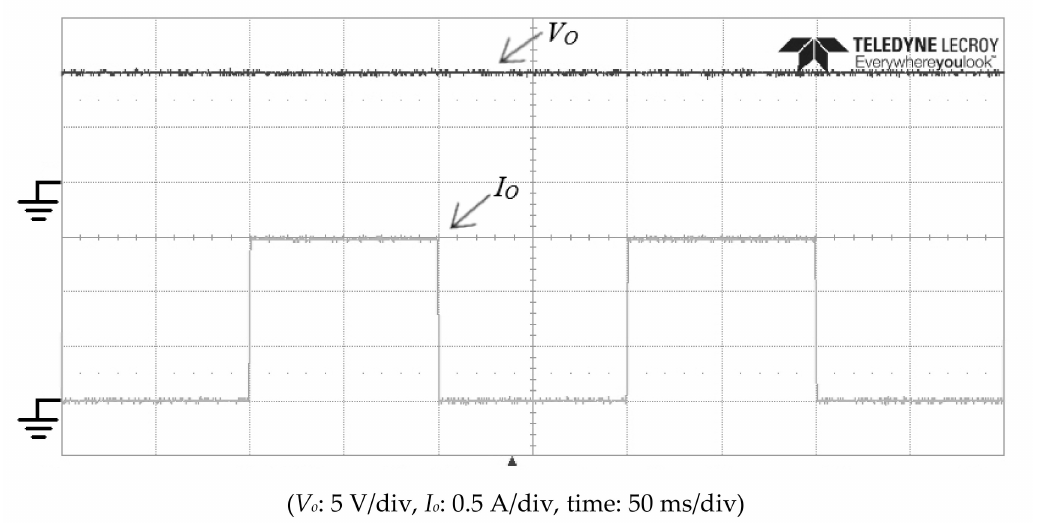
Figure 21. Measured output voltage V o and output currents I o waveforms of the proposed hybrid converter operated in the discharging mode under step-load changes between 0% and 100% of full-load